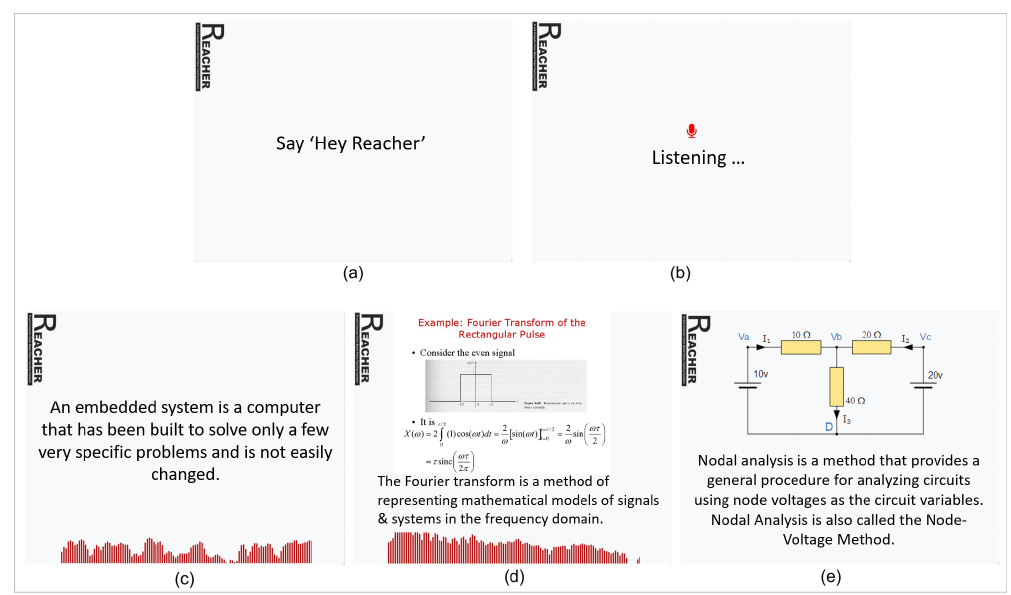
Figure 13. User interface views. ( a ) Shows the main view, ( b ) shows the view when audio is being recorded, ( c – e ) show the different views displayed on receiving definition, example, and images